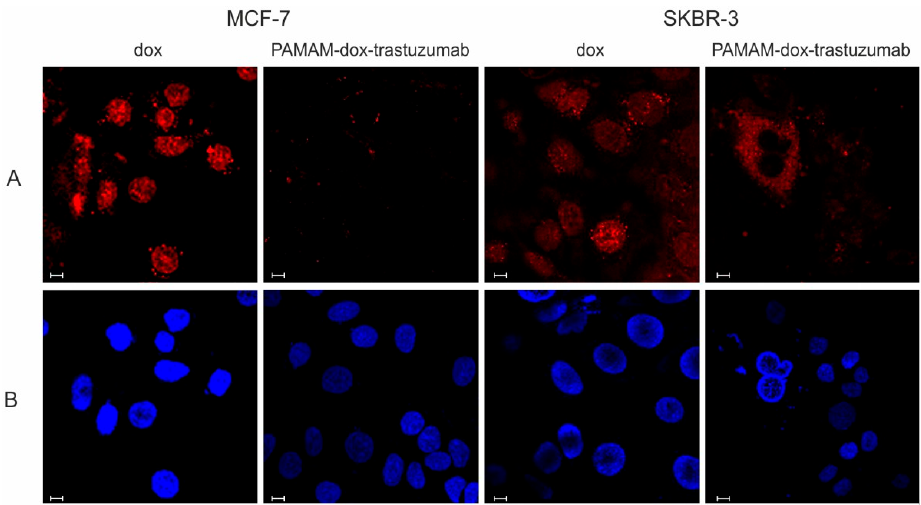
Figure 6. Confocal images of MCF-7 and SKBR-3 cells treated with 1 µM free doxorubicin and PAMAM–dox–trastuzumab conjugate for 24 h. Following doxorubicin and conjugate accumulation (red channel) ( A ), cells were rinsed once with PBS and stained with DAPI to visualize cell nucleus (blue channel) ( B ). The size of the scale bar is 10 nm.